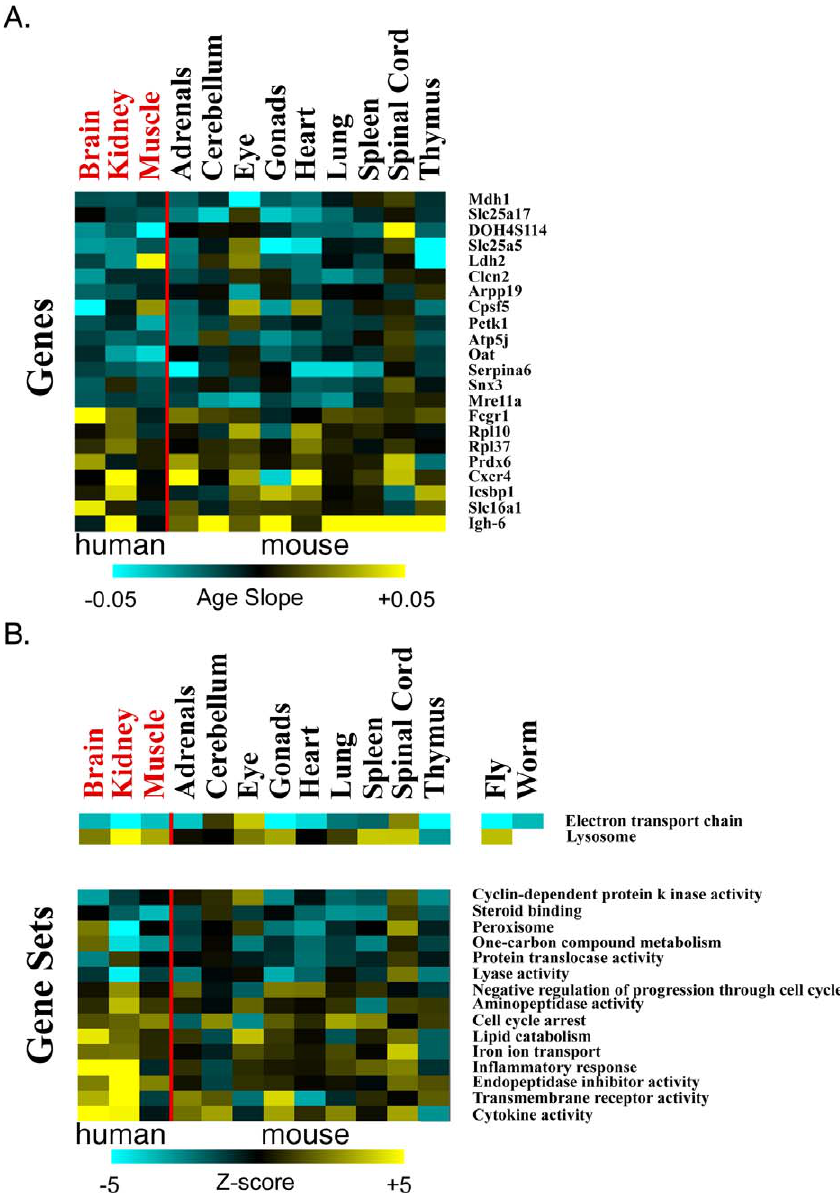
Figure 4. Common Age Regulation in Human, Mice, Flies, and Worms (A) Comparison of age-related expression changes for 2,578 orthologous genes in humans, mice, flies, and worms. Rows correspond to genes, arranged from the genes showing the greatest decrease in expression with age in both human and mouse at top to the genes showing the greatest increase in expression with age in both human and mouse at bottom. Columns correspond to tissues; tissue names are colored to denote their species of origin, either human (red) or mouse (black). Scale corresponds to the slope of the change in log2 expression with age ( b 1j ). (B) Comparison of age-related expression changes for 280 gene sets in humans, mice, flies, and worms. First row is the mitochondrial electron transport chain gene set, which was found to be age regulated in flies and worms in addition to mammals. Second row is the lysosome gene set, which was found to be age regulated in flies in addition to mammals. Other rows correspond to gene groups that are commonly age related in humans and mice alone. Scale refers to a Van der Waerden Z -score. Columns correspond to tissues; tissue names are colored to denote their species of origin, either human (red) or mouse (black). A navigable version of this figure exists at http://cmgm.stanford.edu/ ; kimlab/aging_mouse.